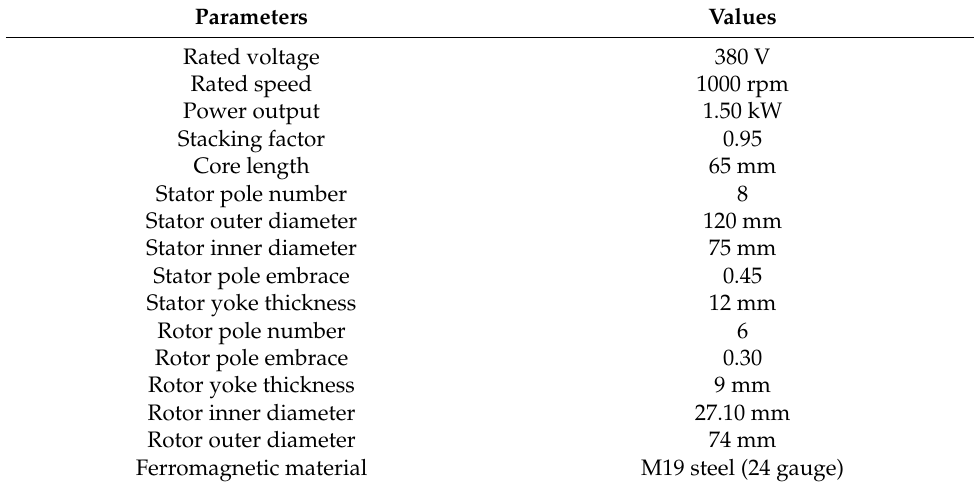
Table 1. Parameters of the